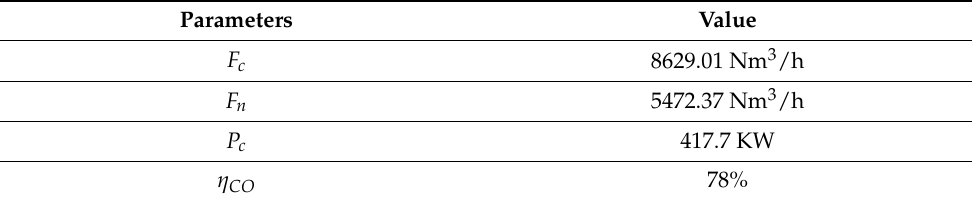
Table 6. List of the calculated FSDS operating performance